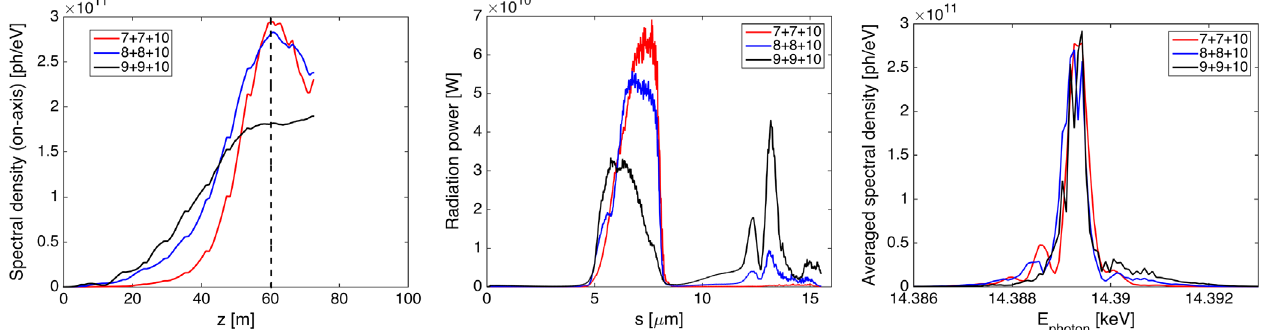
FIG. 9. Maximum on-axis spectral density versus position inside the last radiator with prepulse contributions removed (left). Radiation power (middle) and averaged spectral density (right) at saturation after 10 undulators, for different configurations 7 þ 7 , 8 þ 8 and 9 þ 9 . All plots are the results of an ensemble average over ten